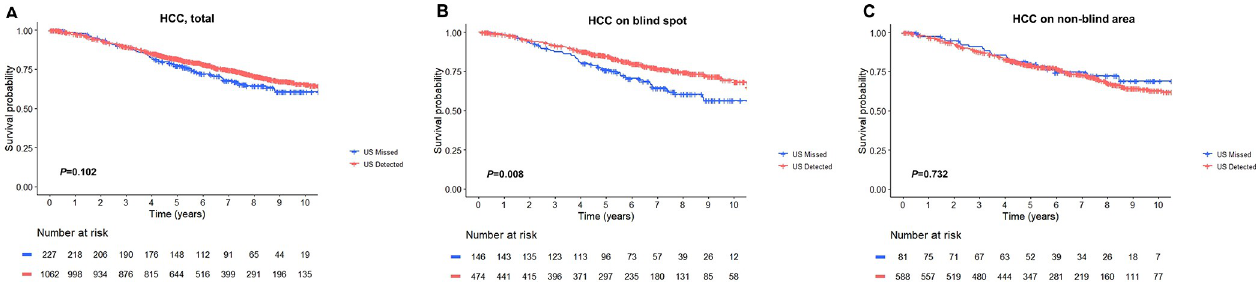
Fig 4. Overall survival of the US-detected versus US-missed groups: (A) entire study population, (B) HCC in a blind spot, and (C) HCC in a non-blind area ( P value calculated by the log-rank test).